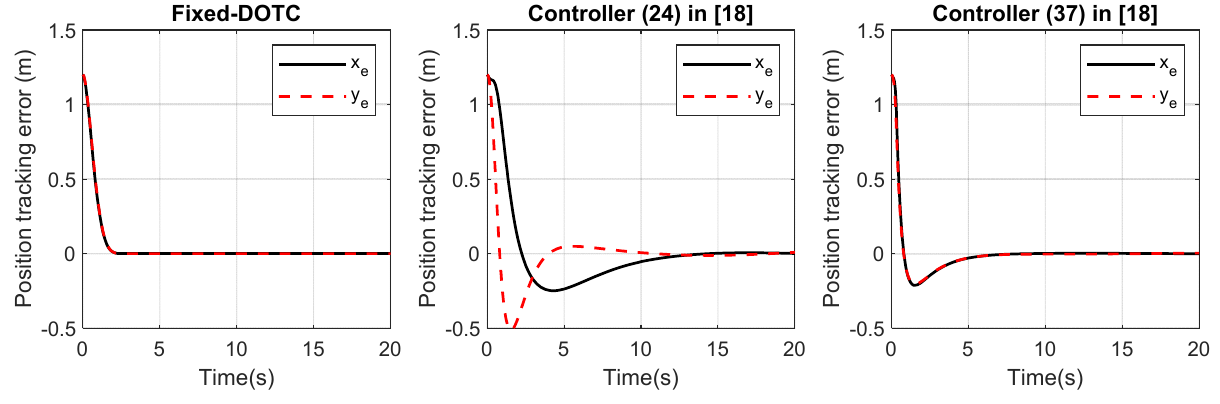
Figure 6. The position tracking errors in part 1.